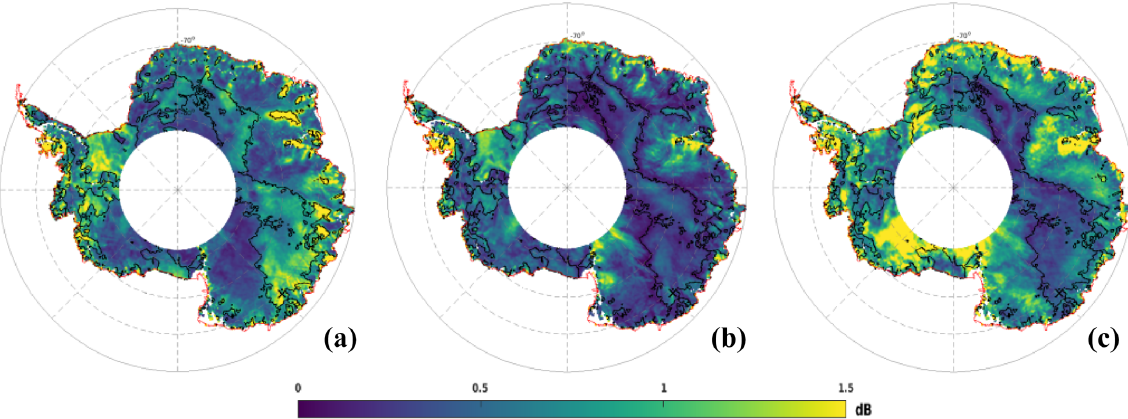
Figure 5. Spatial distribution of the seasonal amplitude of the backscattering coefficient at the S (a) , Ku (b) and Ka (c) bands. Black contour lines delineate regions where the backscattering coefficient at the Ku band peaks before April. The cross mark represents the location of the time series shown in Fig. 1. White areas indicate regions where no observations are available (latitudinal orbit limit of 81.5 ◦ S). Values are expressed in dB.